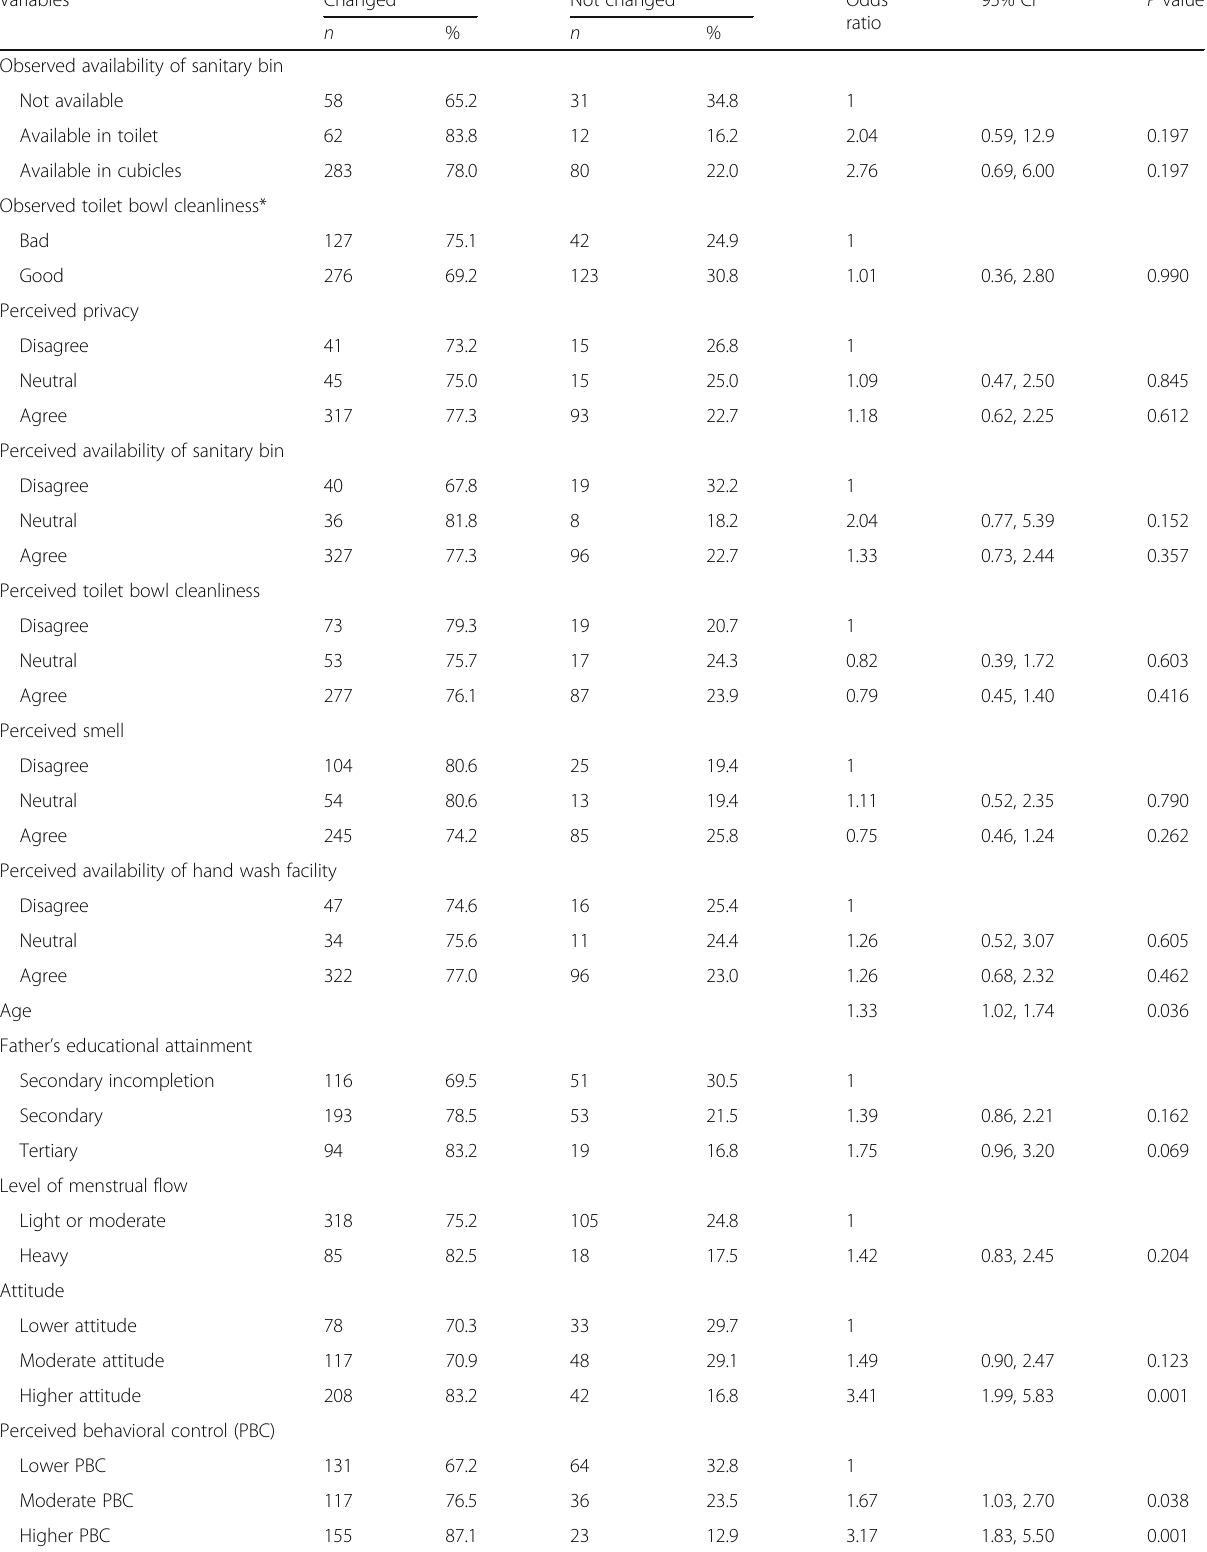
Table 2 Bivariate association with frequency of changing sanitary napkins in school toilets Variables Changed Not